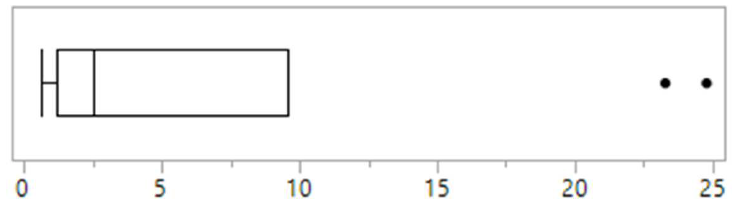
Figure 1. The proportion (%) of disordered eating reported by Australasian tertiary, paediatric type 1 diabetes clinics ( n = 10). Vertical lines in boxplot (left to right) identify minimum, first quartile, median and third quartile values.